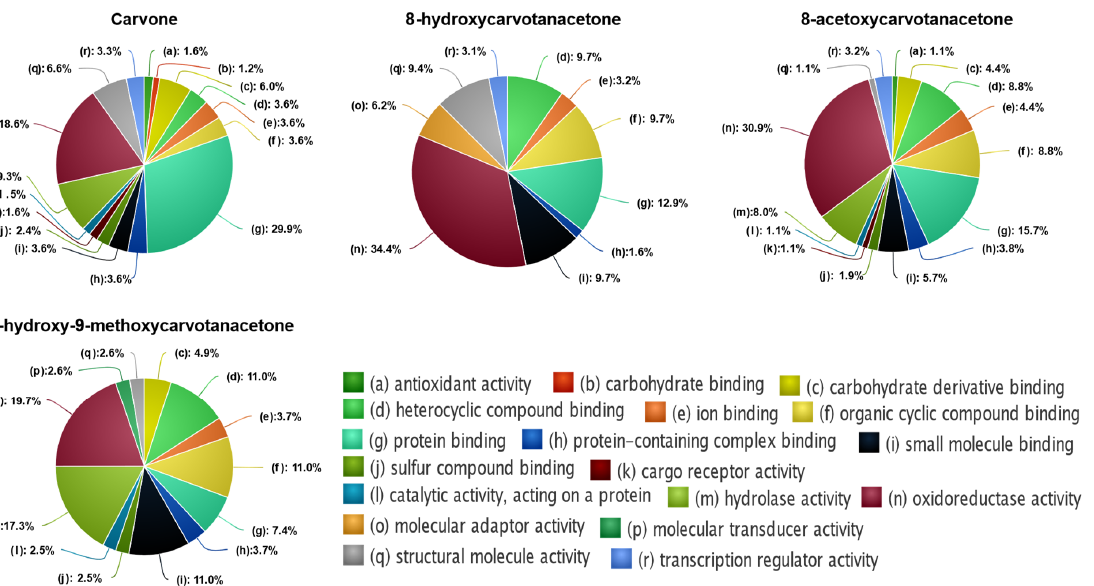
Figure 6. Functional enrichment analysis of cellular processes predicted to be affected by the 4 structures tested, according to DTI prediction model.